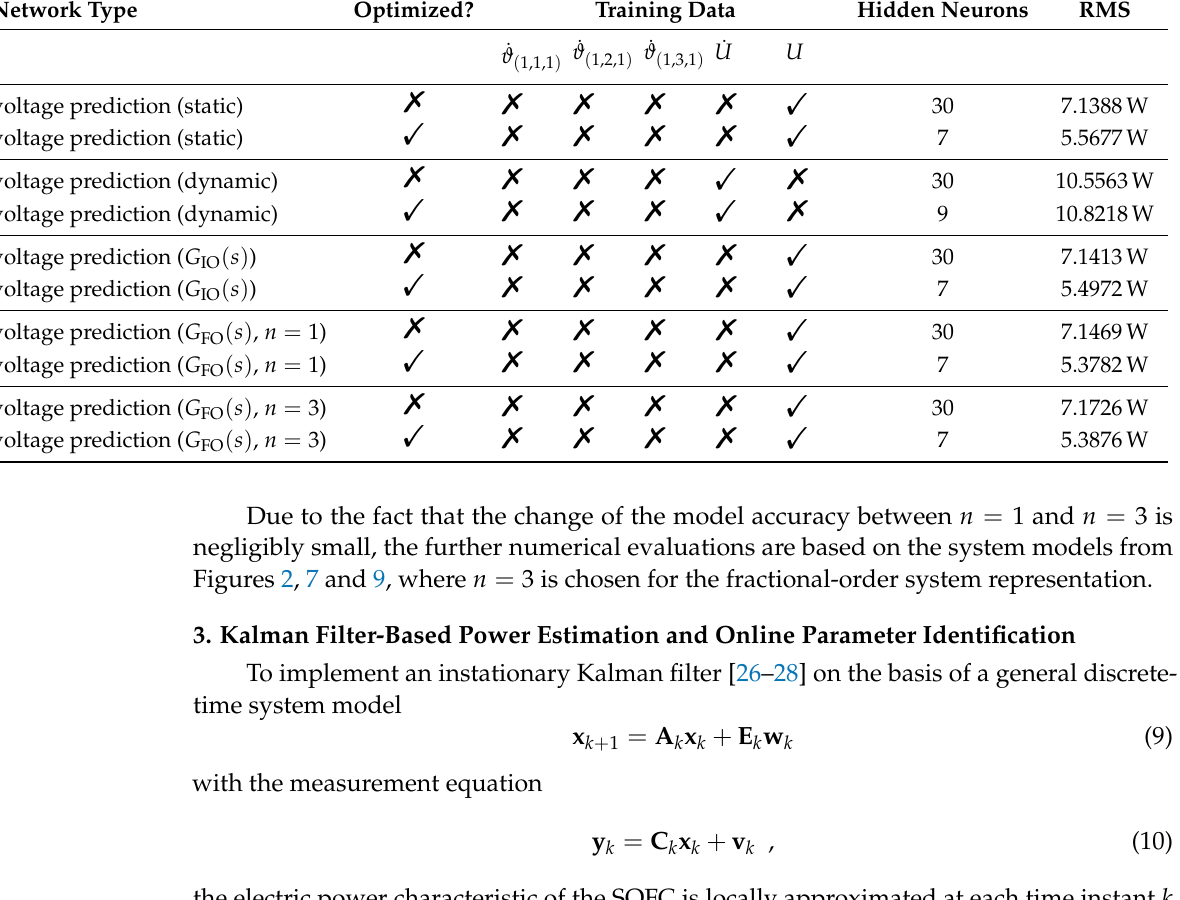
Table 4. Overview of the training and simulation results for the neural network models in Figures 2, 5, 7, and 9. Network Type Optimized? Training Data Hidden Neurons RMS